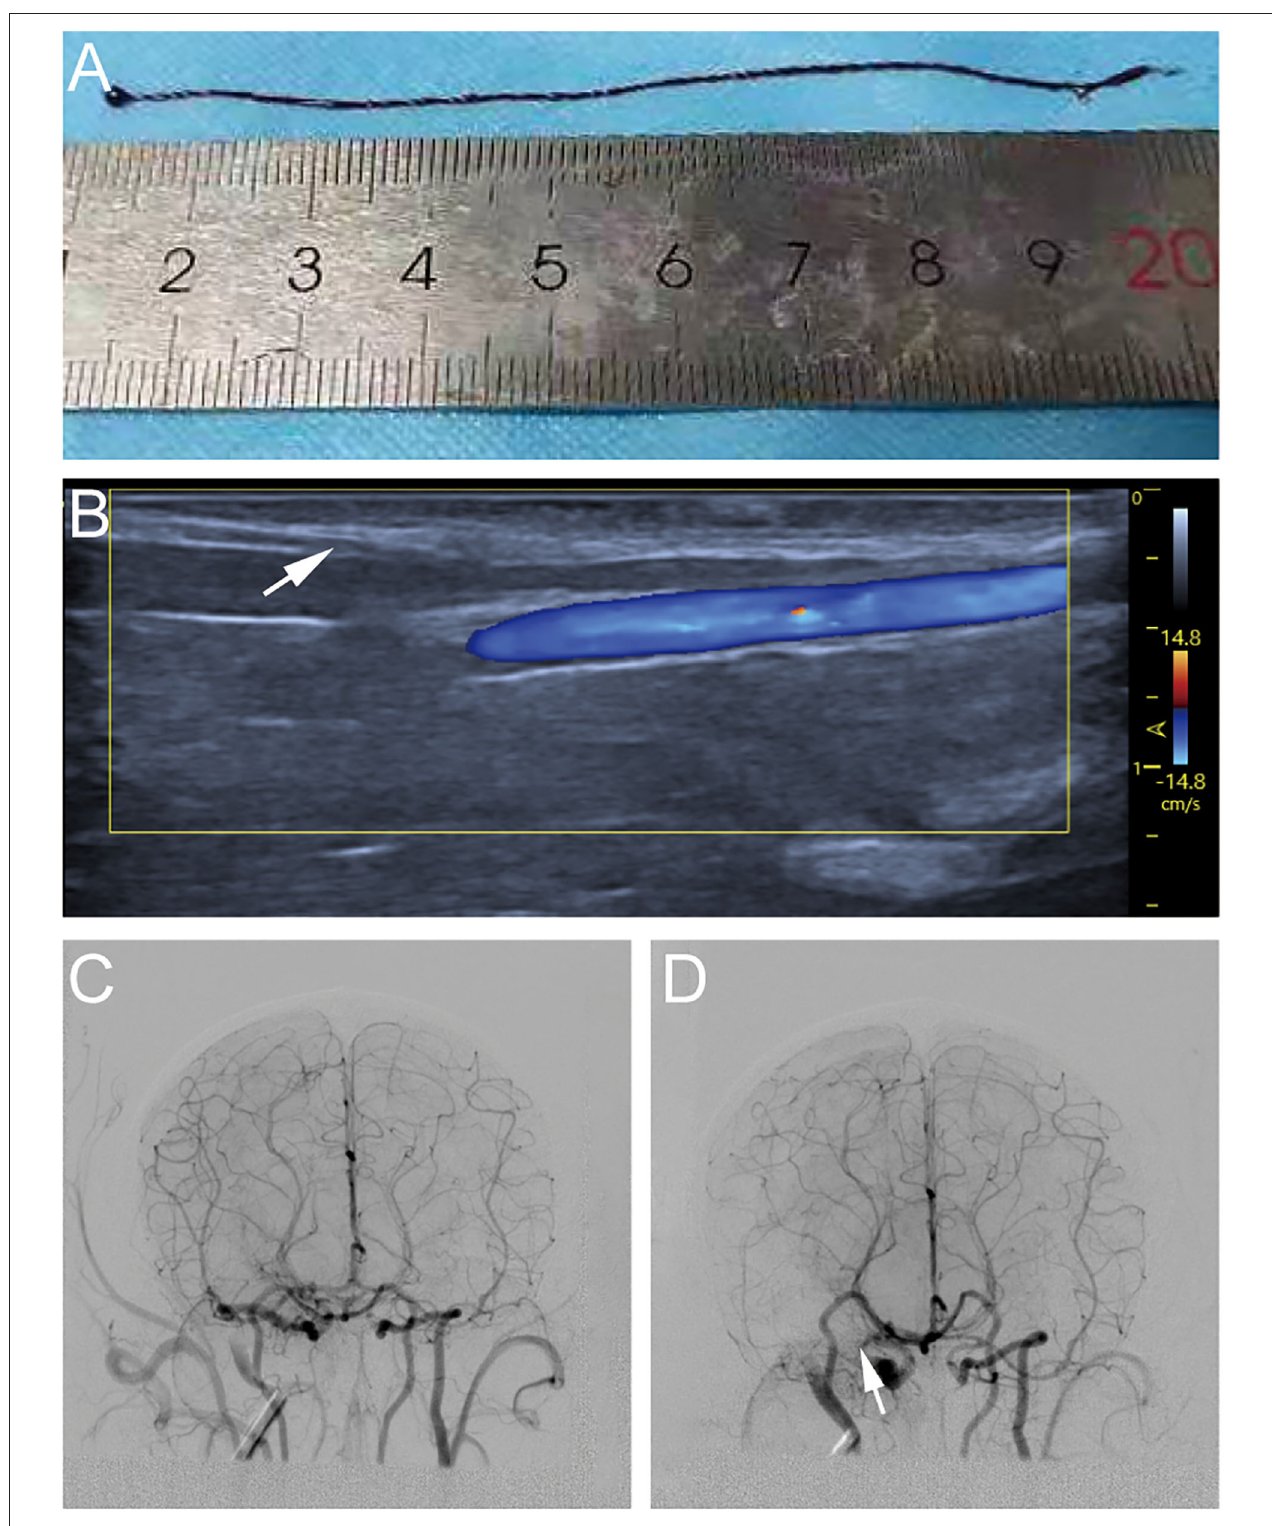
FIGURE 1 | Process diagram of establishing cynomolgus monkey middle cerebral artery occlusion (MCAO) model. (A) Autologous venous thrombosis with a diameter of 0.5mm ofv cynomolgus monkeys required for the experiment. (B) A 4F arterial catheter sheath was inserted through the femoral artery under ultrasound guidance. (C) Cerebral vascular imaging of cynomolgus monkeys under digital subtraction angiography (DSA) angiography. (D) A 5–8cm thrombi was injected into the internal carotid artery ICA via the microcatheter, the right middle cerebral artery (MCA) was not visualized on another angiography.